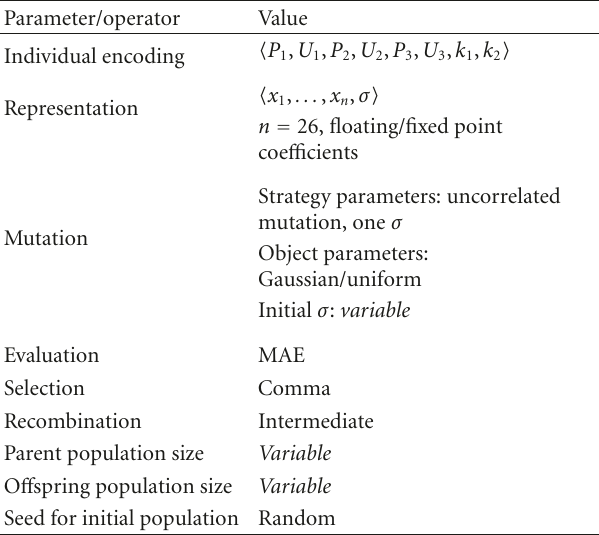
Table 3: Proposed evolution strategy: